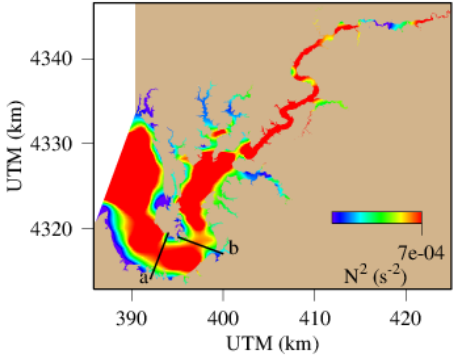
Figure 11. Spatial distribution of maximum buoyancy (squared Brunt – Vaisala Frequency) on 21 July, 2005. ( a ) and ( b ) are two transects where the current fields are depicted in Figure 12.